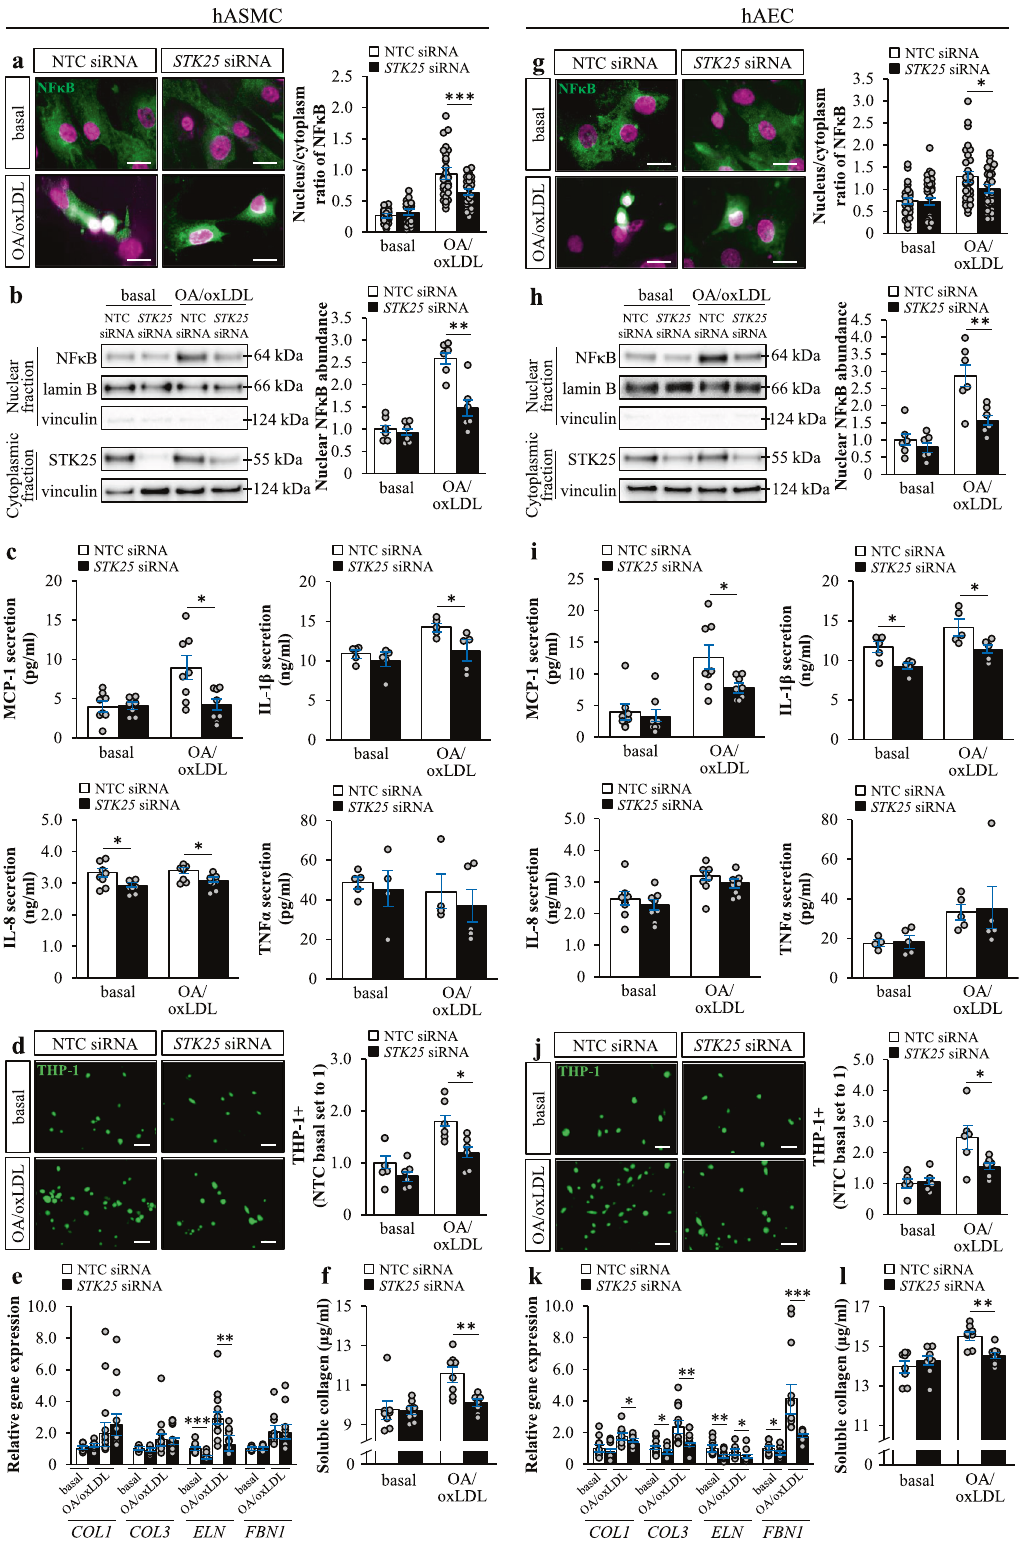
(Fig. 7b, c, Supplementary Table 2). The analysis of phosphopeptide levels, after correction to their corresponding total protein levels, identi fi ed 37 peptides with signi fi cantly different phosphorylation status in STK25-depleted hASMCs. Out of these, the abundance of 21 phosphopeptides was reduced, representing possible target sites for the kinase activity of STK25 (Fig. 7d, e, Supplementary Table